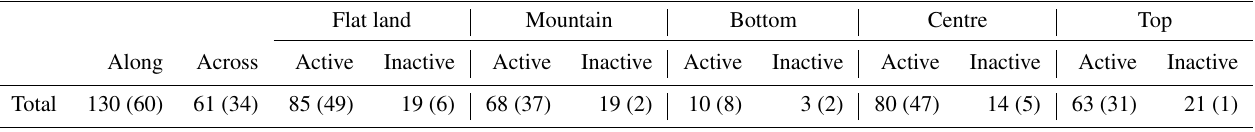
Table 4. Characteristics of the 191 (94) selected cloud transects as defined in Table 3. Numbers in parentheses are relative to the subset of 94 clouds with stricter limits on the cloud gaps. The transects are divided into legs along and across the main wind direction, into legs at the bottom, centre or top of the cloud and the activity status. Active clouds have a positive mean buoyancy inside the cloud. Flat land Mountain Bottom Centre Top Along Across Active Inactive Active Inactive Active Inactive Active Inactive Active Inactive Total 130 (60)